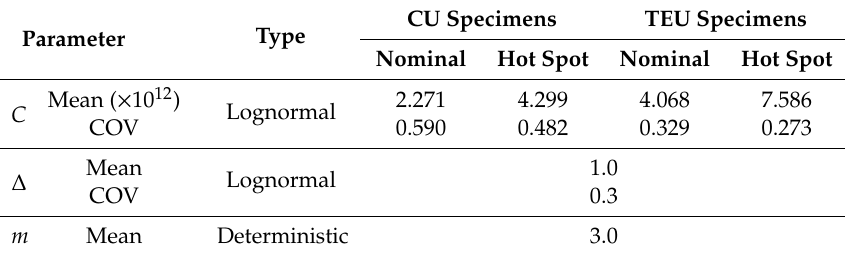
Table 3. Distribution of material